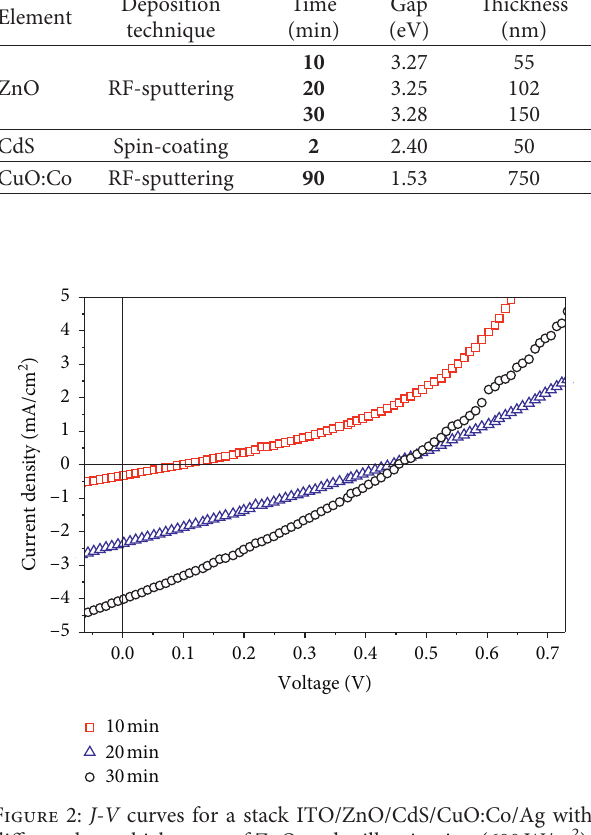
Figure 2: J-V curves for a stack ITO/ZnO/CdS/CuO:Co/Ag with different layer thicknesses of ZnO under illumination (600 W/m 2